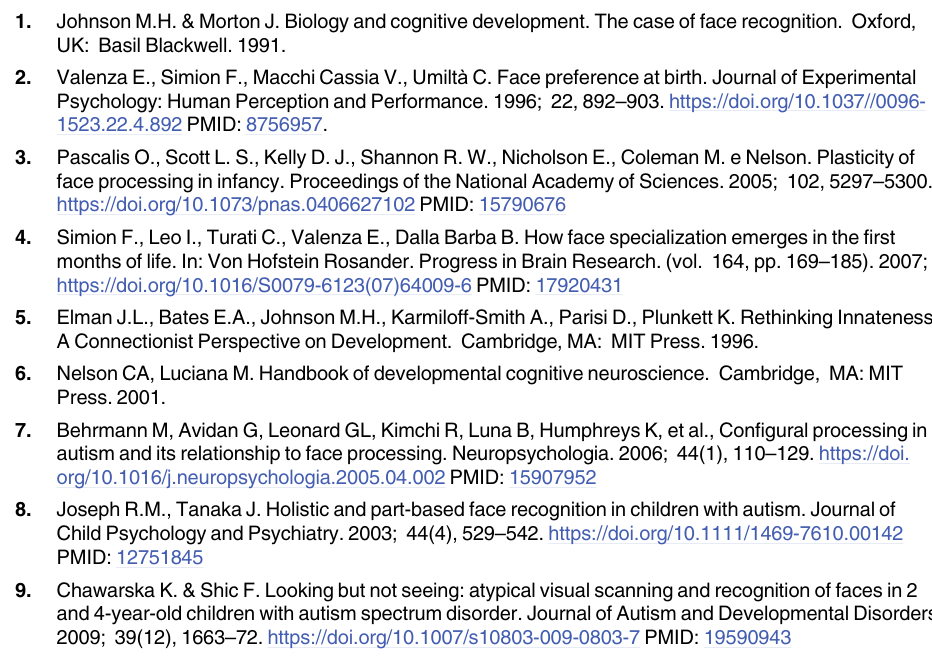
S3 Fig. Frequency density plot. Target detection times in milliseconds per group i.e., TD and ASD. Moreover, considering four AOIs i.e., eye = upper face, mouth = lower face, not-face eye = upper scrambled-phase, not-face m = lower scrambled-phase stimulus. Plots reflect only a sub-sample of participants (12 TD and 7 ASD) that reached at least three valid trials for each AOIs (in each condition and for each stimulus).